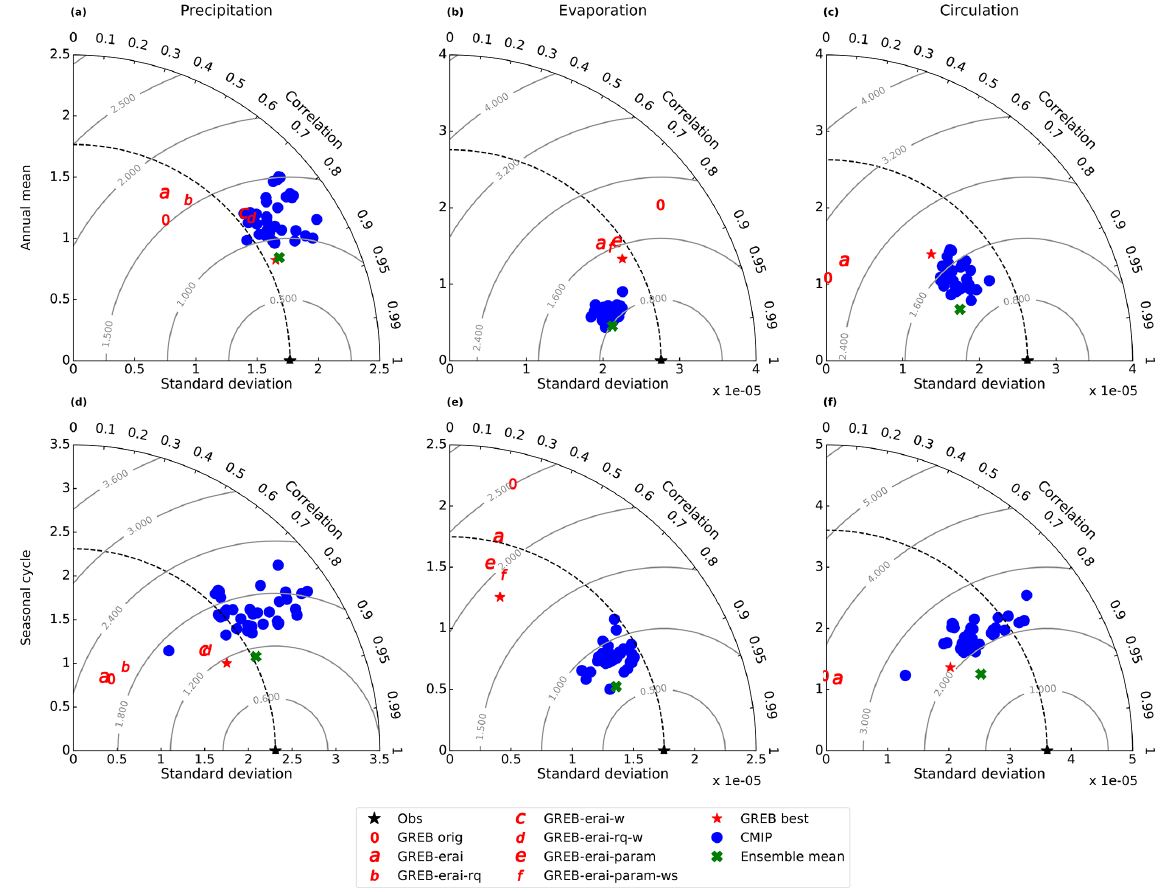
Figure 4. Precipitation (a, d) , evaporation (b, e) and circulation (c, f) in the annual mean (a, b, c) and seasonal cycle (d, e, f) in mmday − 1 in a Taylor diagram against observations from GPCP and ERA-Interim. Red colours indicate different GREB parameterisations, with 0 being the original and red (cid:70) the best parameterisation. Blue dots are pi-Control CMIP5 models, and the green cross indicates the ensemble mean of all CMIP5